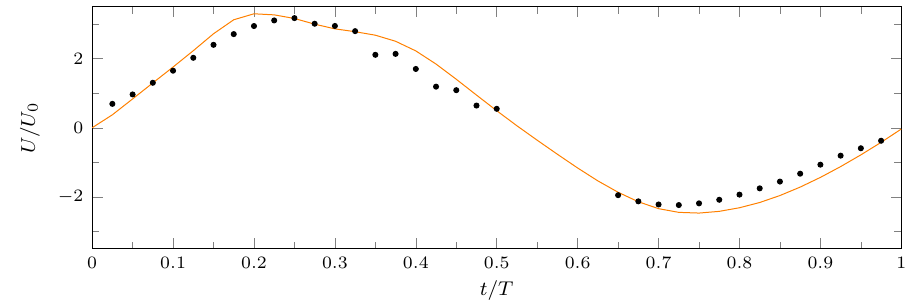
Figure 5. Time history of the centerline phase-averaged streamwise velocity at the 2nd slot exit; numerical (solid line), experimental ( •